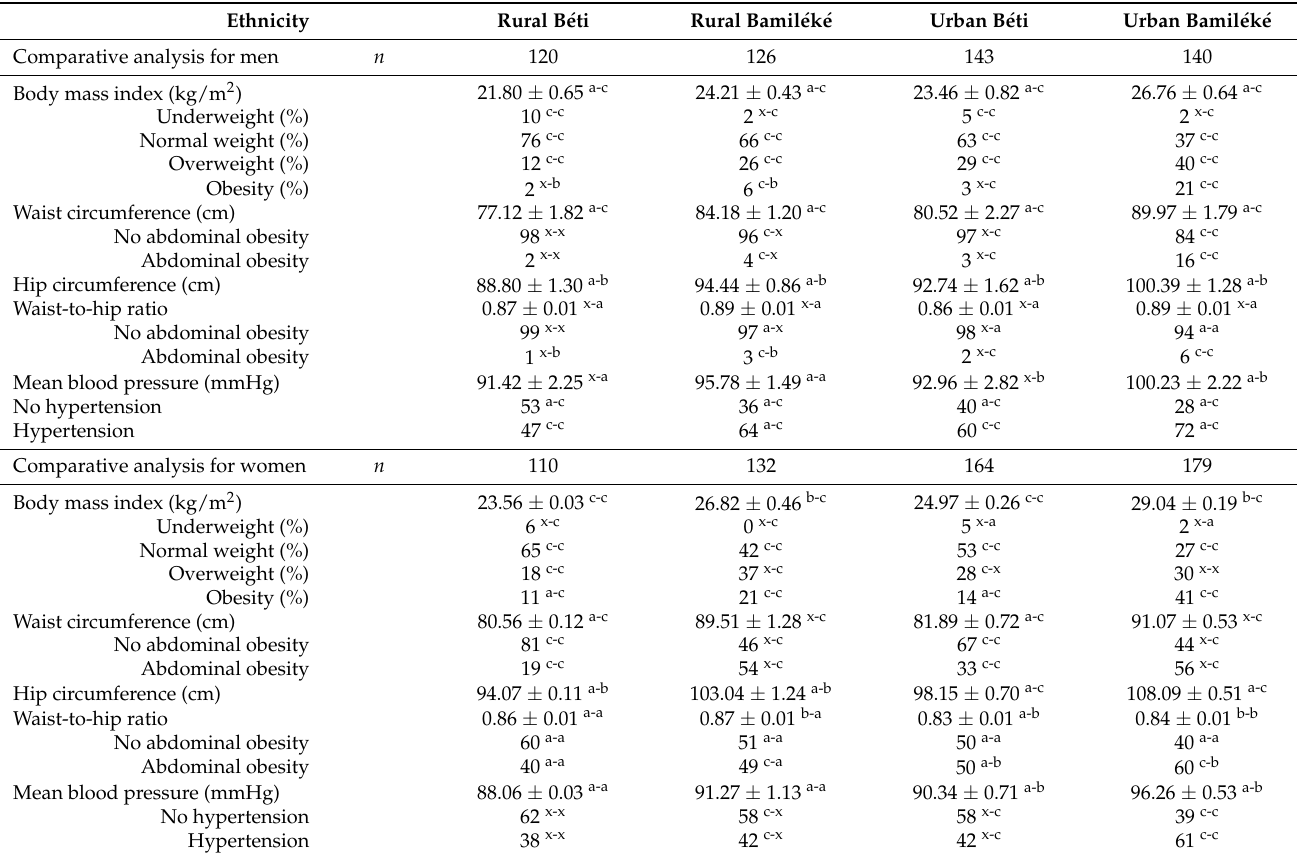
Table 3. Biometrics between B é ti and Bamil é k é in rural and urban areas 1